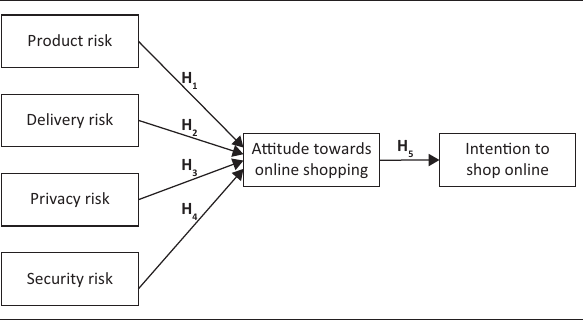
FIGURE 1: Conceptual model